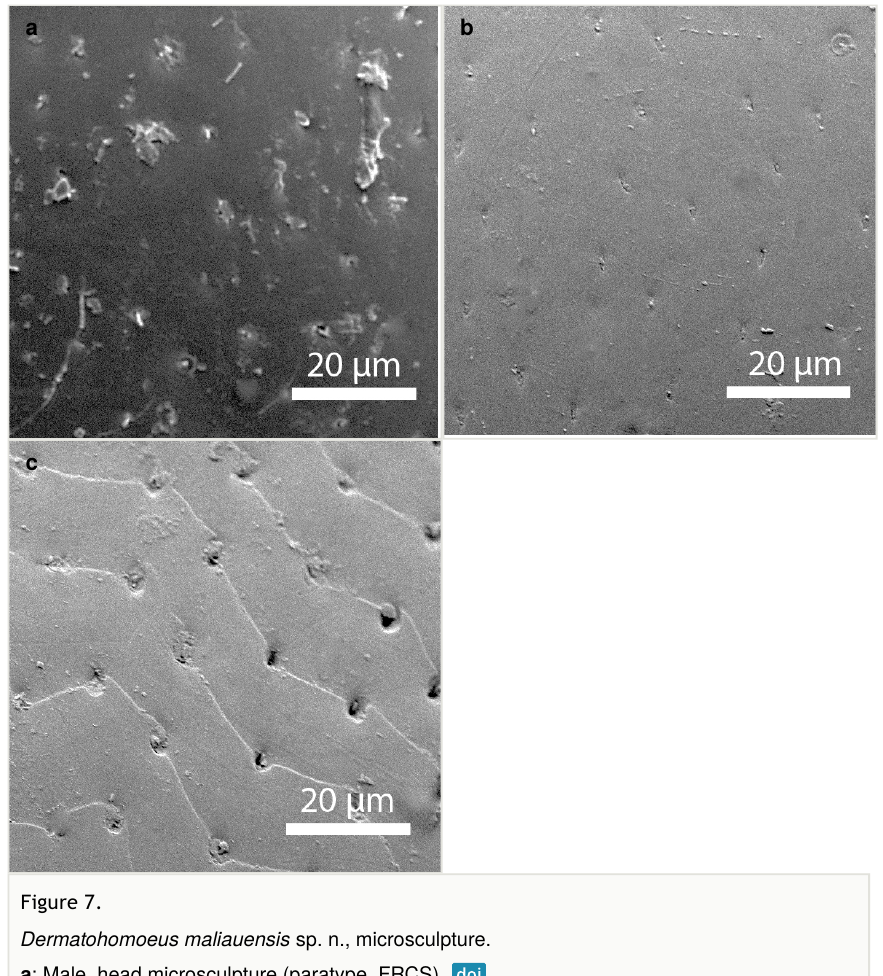
Figure 7. Dermatohomoeus maliauensis sp. n.,